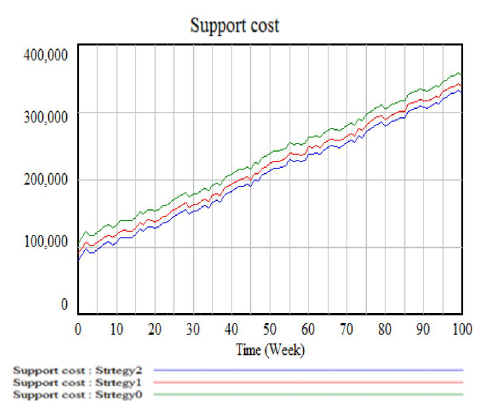
Figure 11. Warship Support cost Figure 12. Operational availability